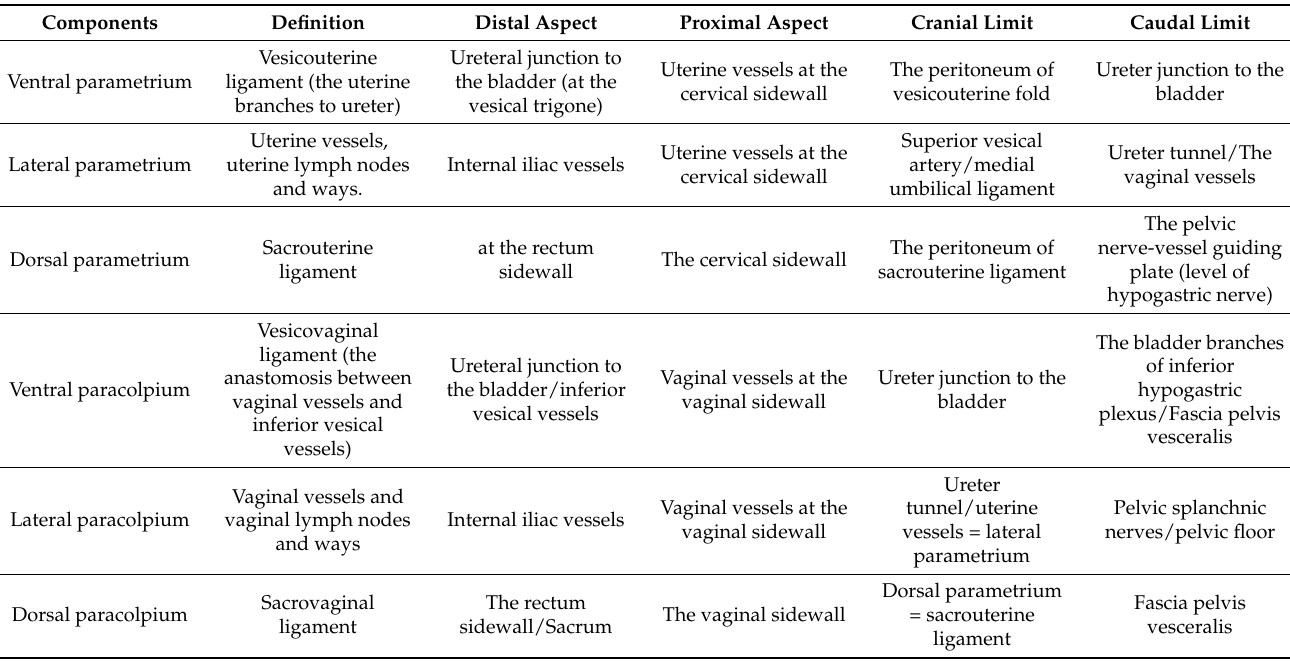
Figure 4. The three-dimentional paracolpium in a cross-section direct above the pelvic floor with the explanation of distal and proximal aspects of ventral, lateral and dorsal paracolpium and the resulted type III and type IV radical hysterectomy. Table 1. Definitions of parametrium and paracolpium components and detailed description of their proximal and distal aspect as well as the cranial and caudal